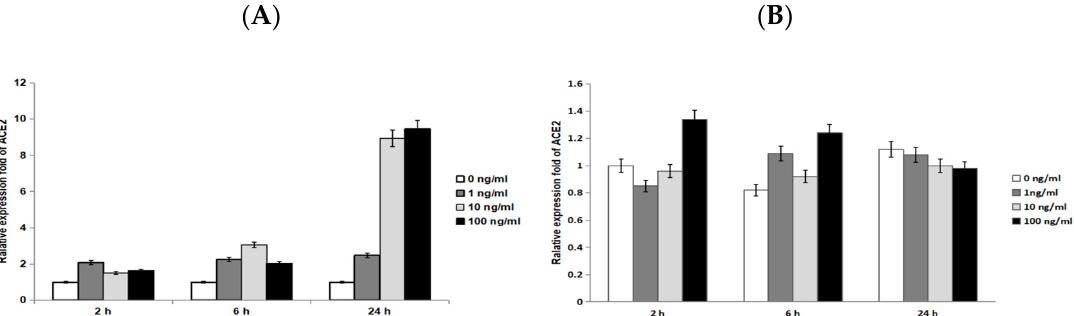
Figure 2. IL-33 enhanced the mRNA expression of ACE2 in a time-dependent manner. We performed quantitative RT-PCR for measuring ACE2 mRNA expression in keratinocytes treated with IL-33 ( A ) or IL-17 ( B ) at indicated time points. The results showed that IL-33 enhanced the mRNA expression of ACE2 in a time-dependent manner, but not in a dose-dependent manner ( A ). On the other hand, IL-17 did not enhance the ACE2 mRNA expression ( B